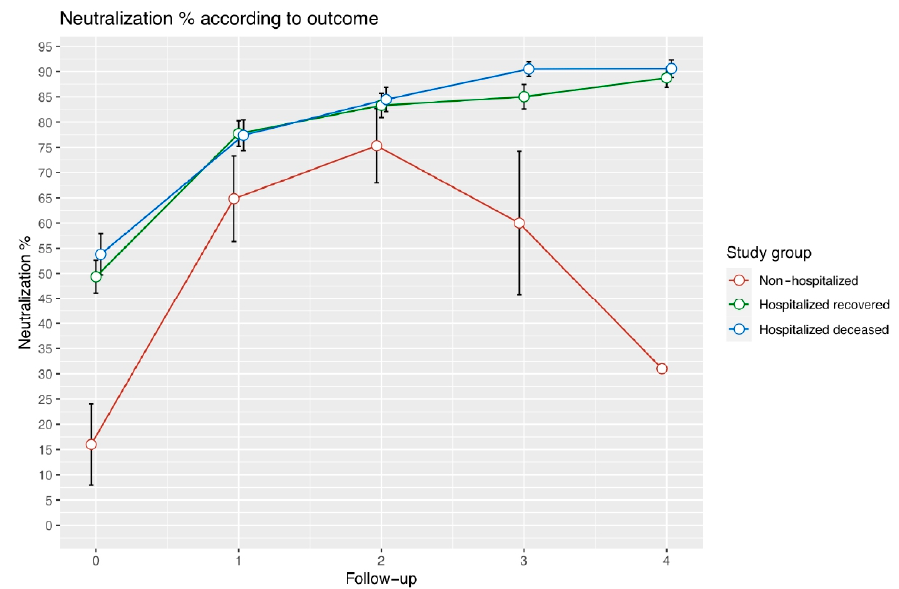
Figure 1. Longitudinal measurements of neutralizing antibodies in different groups of severity. Lineplot representing inhibition percentage kinetics of neutralizing antibodies through four longitudinal measurements. Each point represents the median neutralization value with standard error for that follow-up. The non-hospitalized group is represented by the orange line, the blue line represents recovered hospitalized patients, and the purple line represents deceased hospitalized patients.